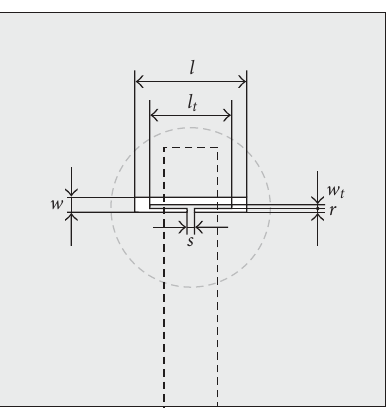
Figure 5: Geometry of the modified slot coupling. Inside the slot a parasitic reactive dipole provides higher harmonic rejection.